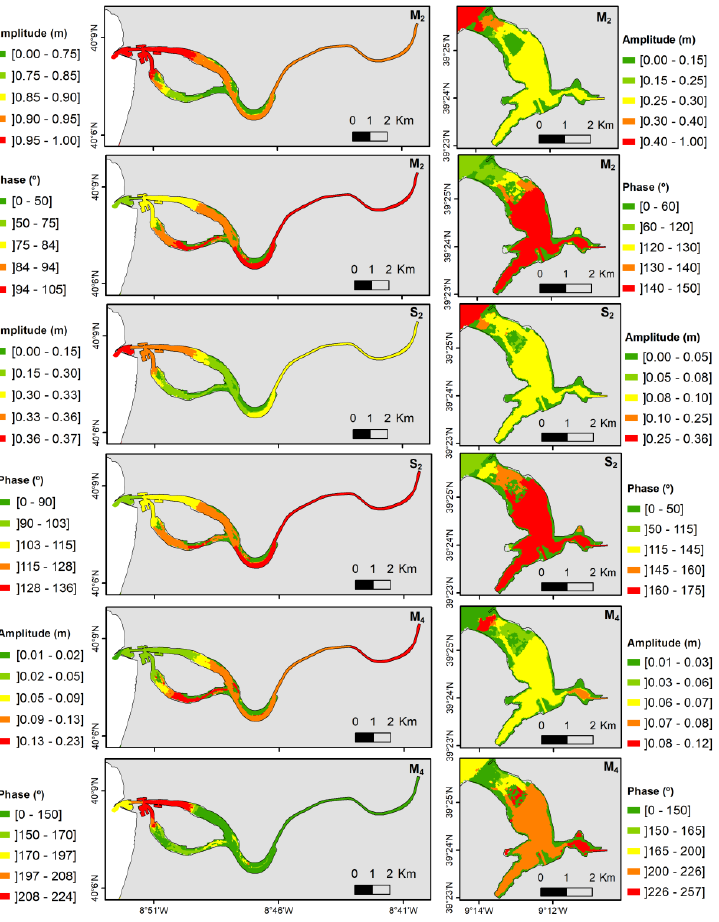
Figure 6. Amplitude (m) and phase (°) of the main tidal constituents for Mondego estuary (left) and Ó bidos Lagoon (right).